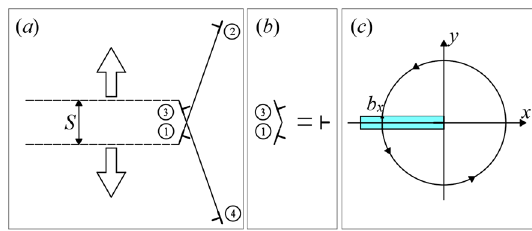
Figure 3 Edge dislocation and its dipole diagram: a Dislocation dipoles; b crack tip dislocations; c edge dislocation of the Mode-I